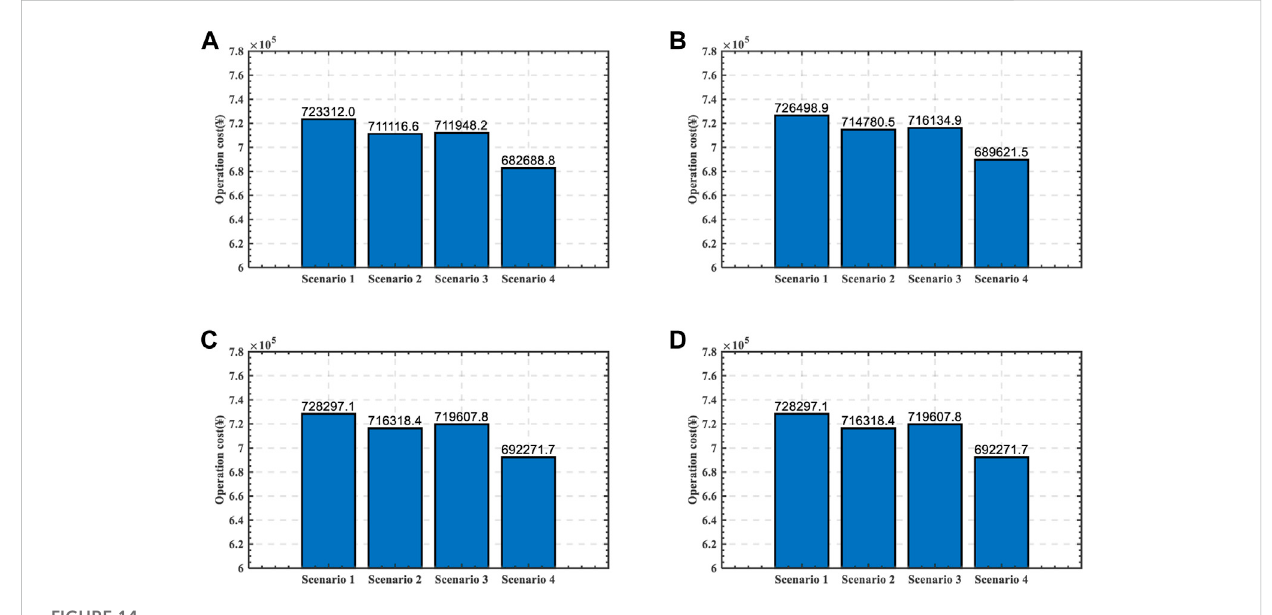
FIGURE 14 The operation cost of DN for the shortest travel time